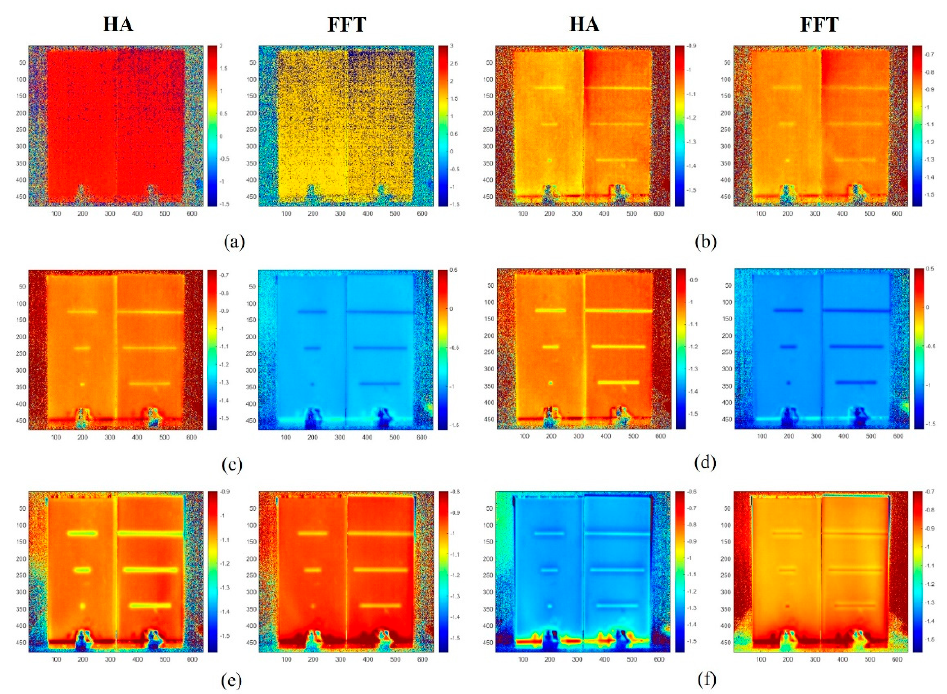
Figure 9. Processed images with HA and FFT algorithms for detecting defects in group 2 of samples at different modulation frequencies: ( a ) 1 Hz, ( b ) 0.2 Hz, ( c ) 0.1 Hz, ( d ) 0.05 Hz, ( e ) 0.03 Hz, and ( f ) 0.01 Hz.